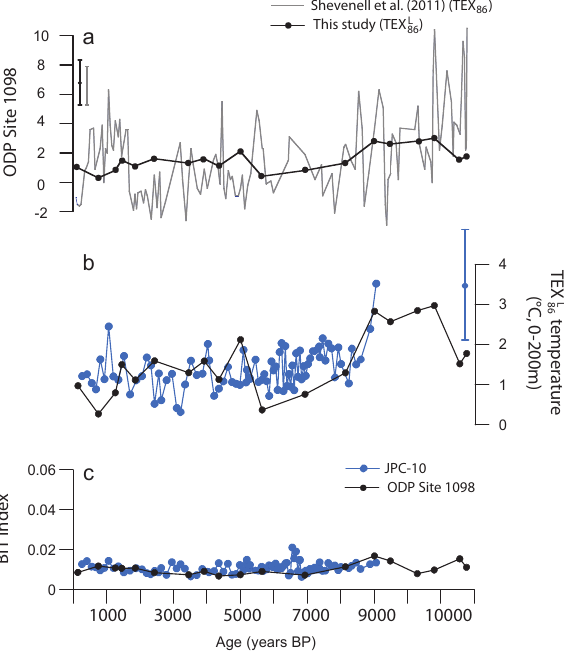
Fig. 4. (a) TEX L (this study) versus TEX 86 (Shevenell et al., 2011) 86 records at ODP Site 1098. (b) JPC-10 and ODP Site 1098 TEX L records. Temperature total errors are indicated by vertical bars for each record with their respective colors. (c) JPC-10 and ODP Site 1098 BIT index records. Note the different temperature scale used between (a) and (b) due to the different temperature amplitude re- sulting from the application of two different indices and two differ- ent